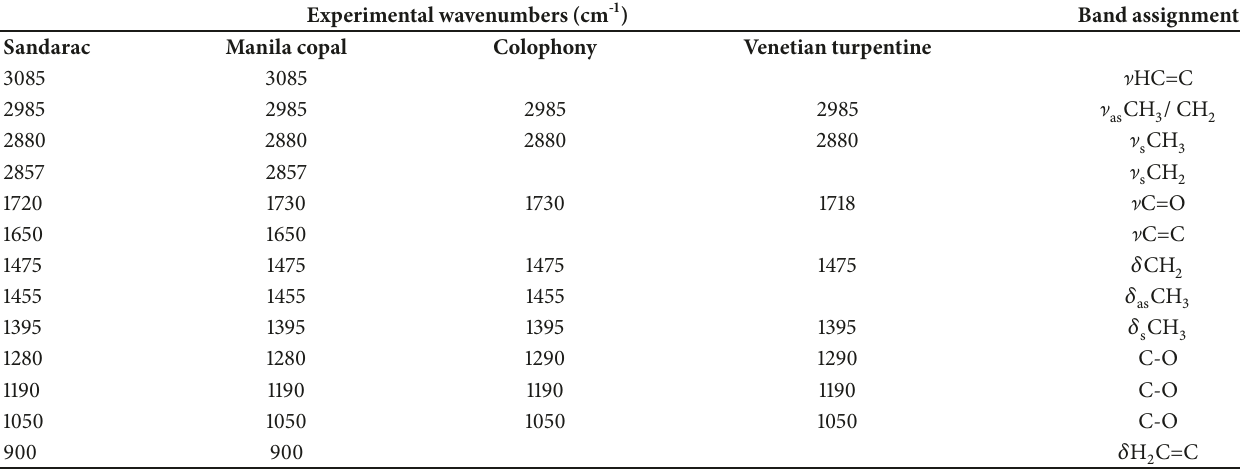
Table 5: Experimental wavenumber values corresponding to the maxima of the mid-IR total reflection mode bands of diterpenoid resins and their tentative assignment.